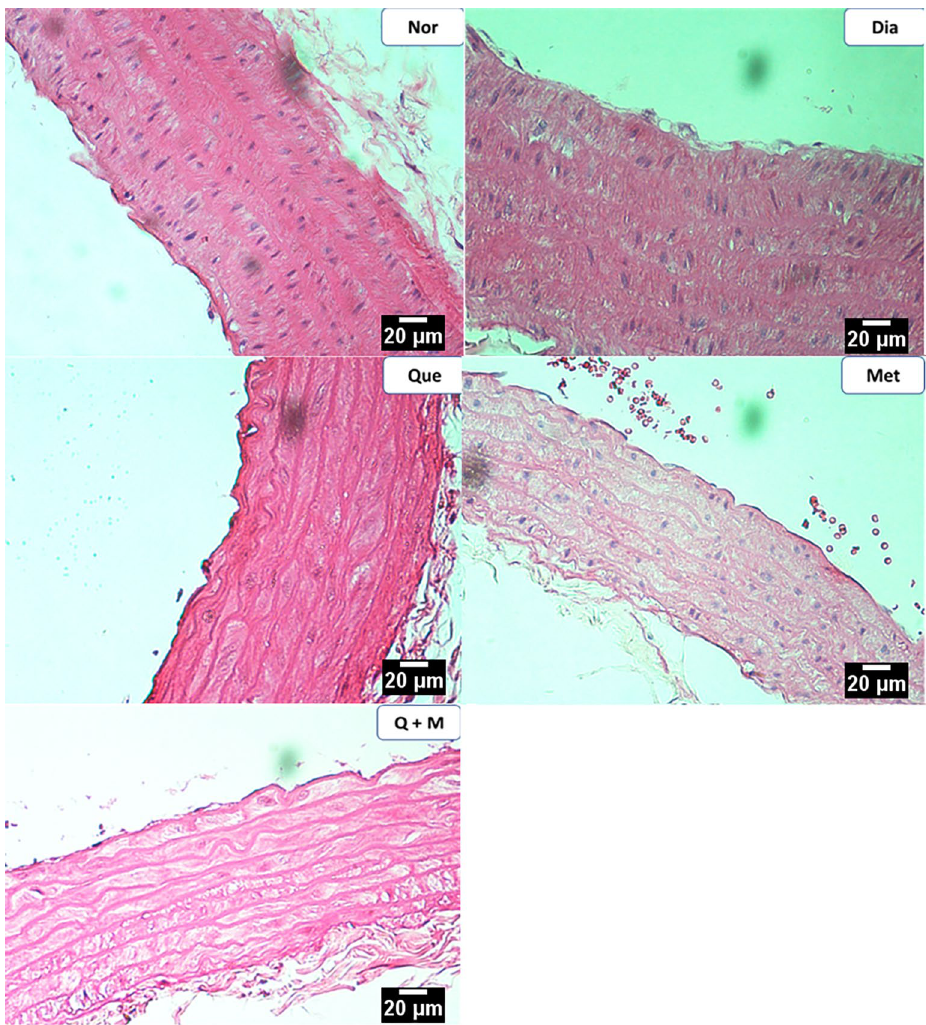
Figure 8. The effect of test compounds on thoracic aortae histology in diabetic rats. Nor Normal, Dia Diabetic, Que Quercetin treated, Met Metformin treated, Q + M Quercetin + metformin treated diabetic